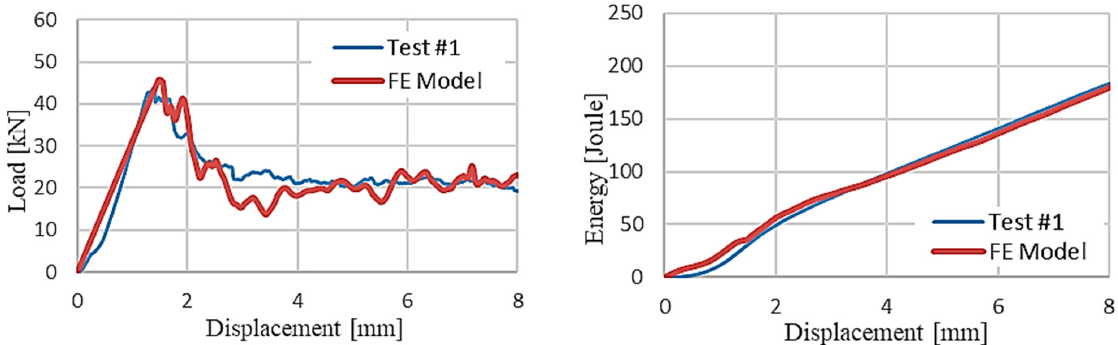
Figure 17. Comparison of the FE model (with a plug-initiator) with experimental tests: load-displacement curves ( left ) and energy curves ( right ) of the sinusoidal with 3 curvatures.